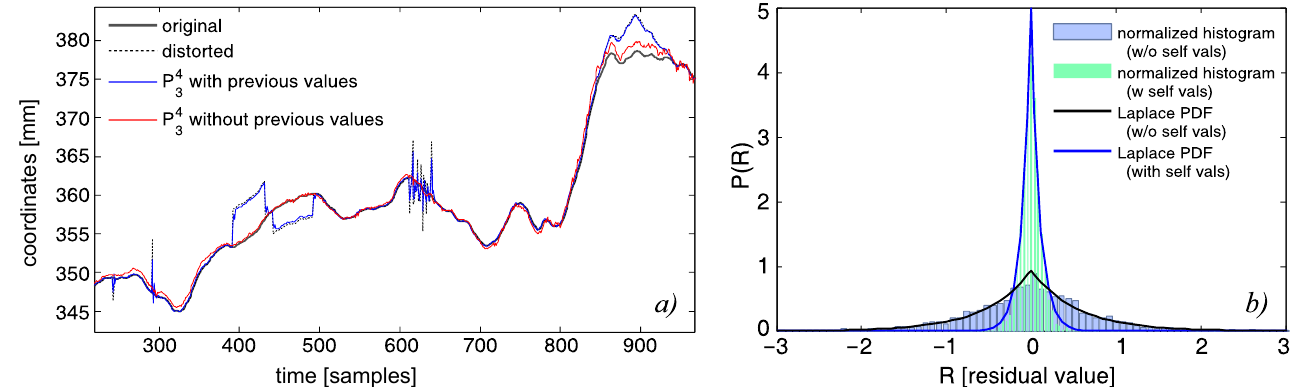
(with and without former values of the 3 (for explanation of the model construction and 3